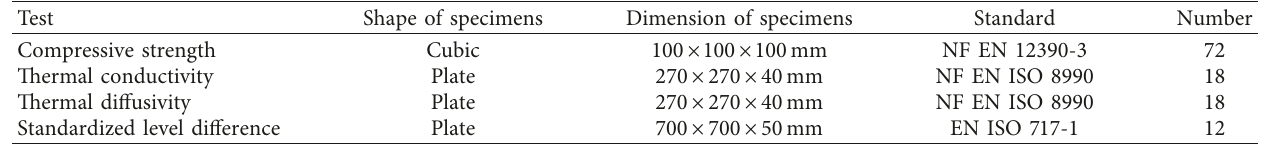
Table 4: Dimensions and shape of the tested specimens.